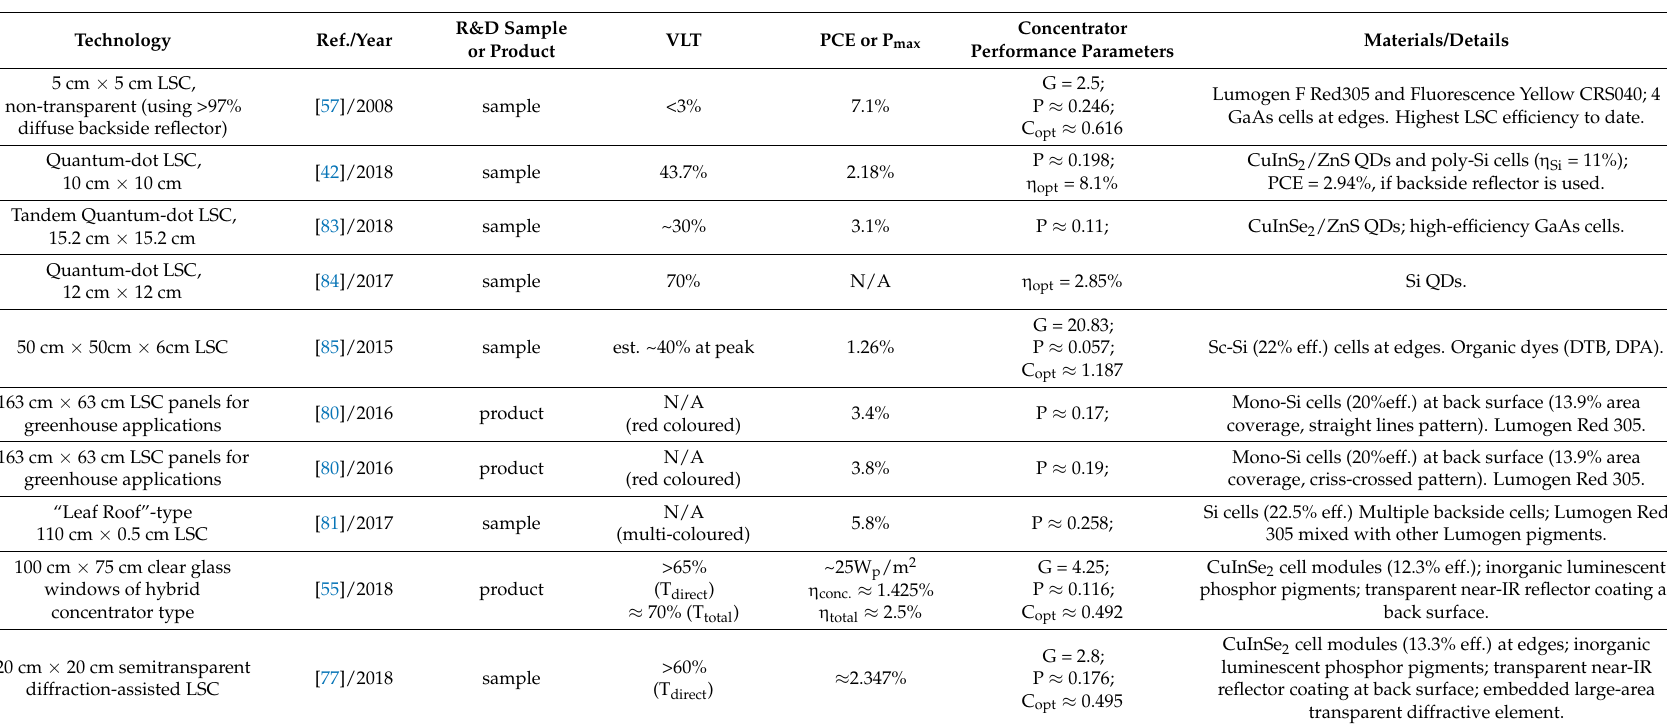
Performance summary for main recently-reported concentrator-type semi-transparent luminescent solar concentrator (LSC) devices and solar window